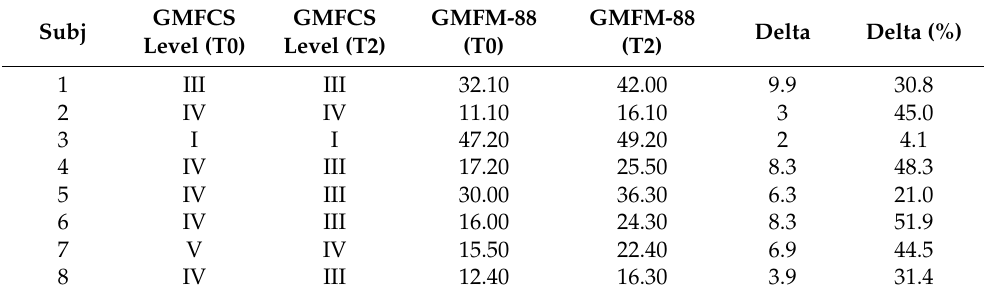
Table 1. GMFM-88 and GMFCS level improvements for each participant between T0 and T2 associated with